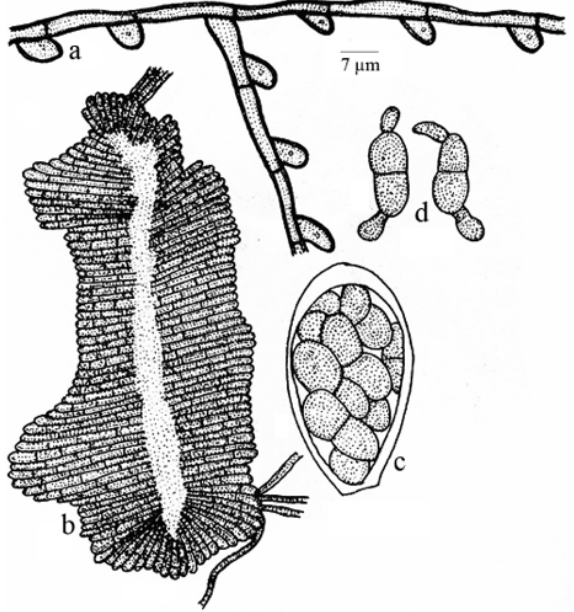
Figure 182. Lembosia hosagoudarii a - Appressoriate mycelium; b - Thyriothecium; c - Ascus; d -